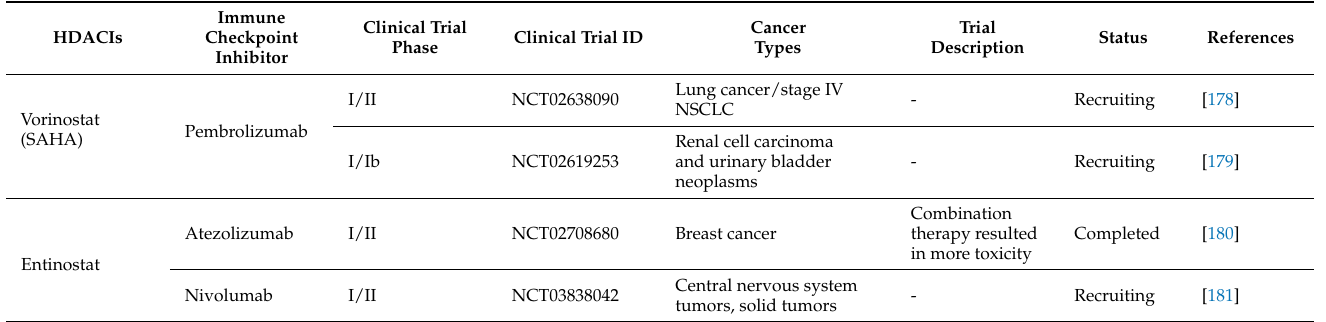
Table 4. Clinical trials of HDAC inhibitors in combination with immune checkpoint